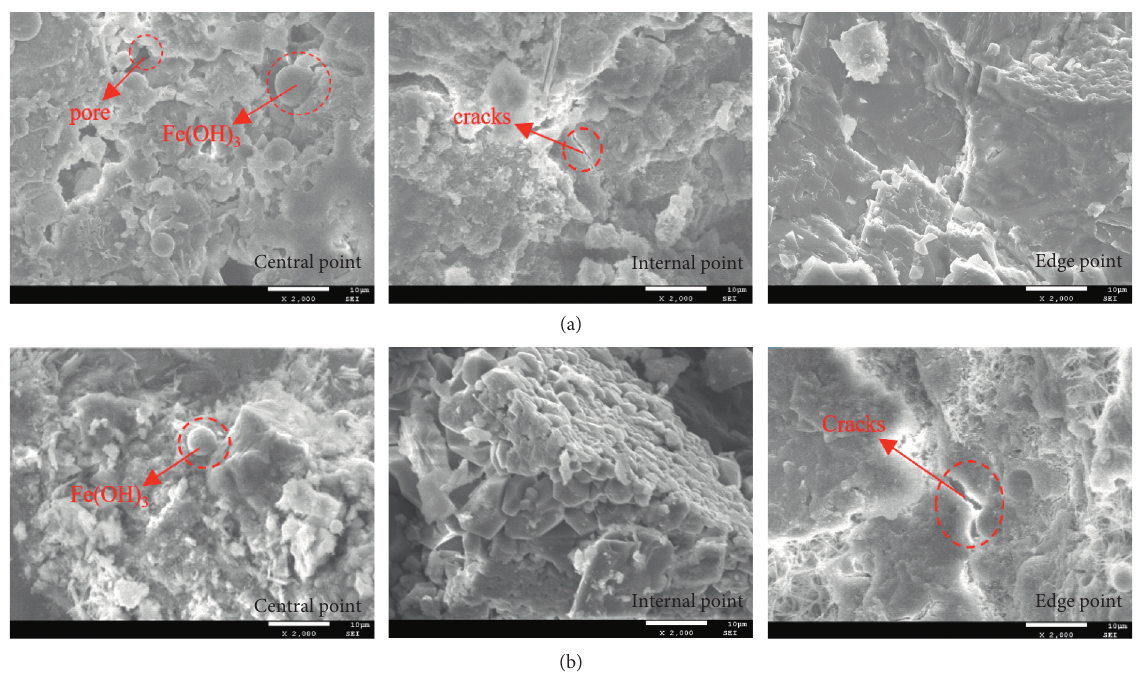
Figure 12: Electron microscope scans of 12% theoretical corrosion ratio. (a) 0 cycles of freeze-thaw with 12% corrosion group. (b) 200 cycles of freeze-thaw with 12% corrosion group.